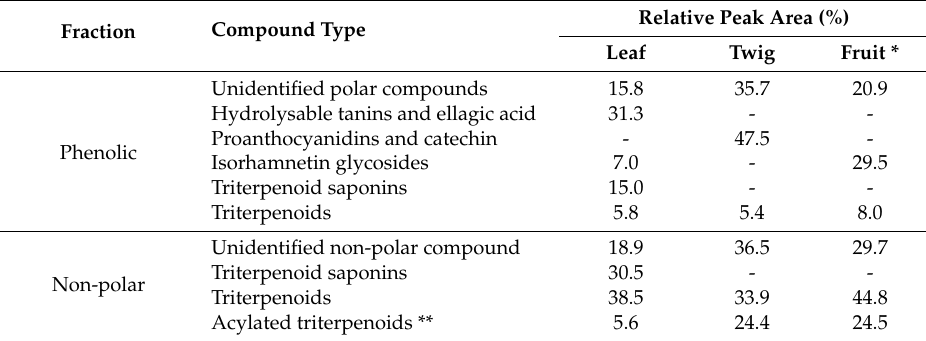
Table 1. The relative content of selected individual groups of compounds in the phenolic and non-polar fractions of leaf, twig and fruits of sea buckthorn extracts, expressed as a percentage of total peak area (Corona charged Aerosol Detector). Values above 5% are